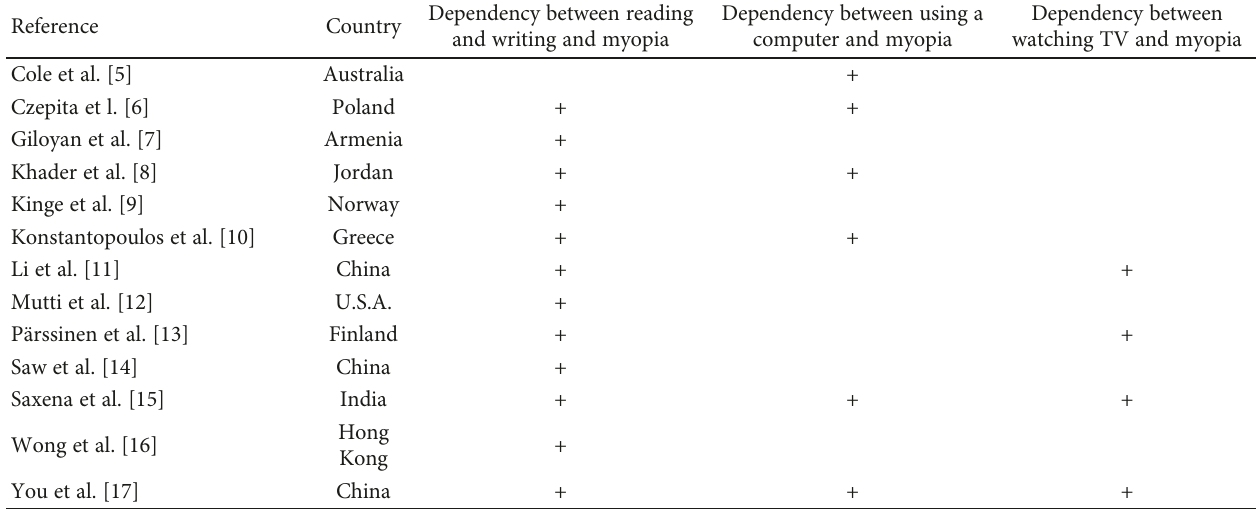
Table 1: Dependency between reading, writing, using a computer, or watching TV and myopia.